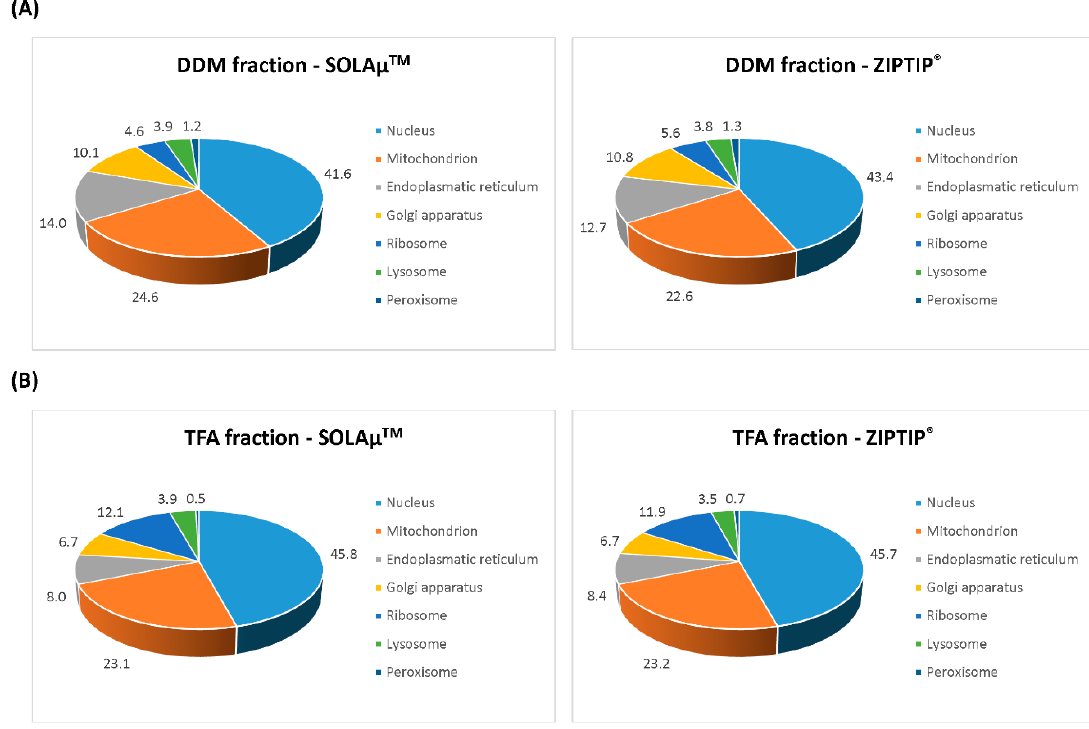
Figure 6. Gene ontology (GO) annotation analysis of all identified porcine retinal proteins. Proteins were clustered according to their cellular compartments such as nucleus, mitochondrion, endoplasmatic reticulum, golgi apparatus, ribosome, lysosome or peroxisome. DDM ( A ) as well as TFA fraction ( B ) did not show any conspicuous differences regarding the cellular localization of the identified proteins between both SPE-based purification methods (SOLAµ TM and ZIPTIP ® ).